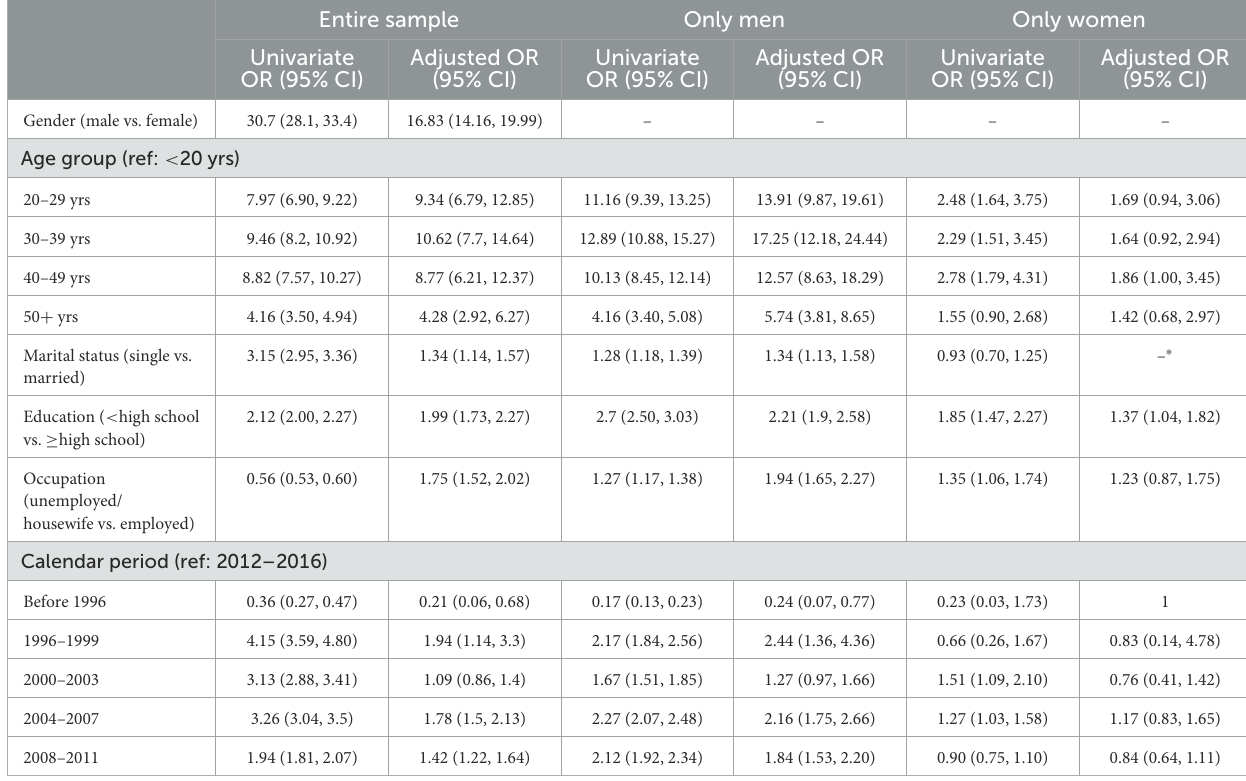
TABLE 3 Socio-demographic and background characteristics associated with the acquisition of HIV through injection drug use in the entire sample. Entire sample Only men Only women Univariate OR (95%